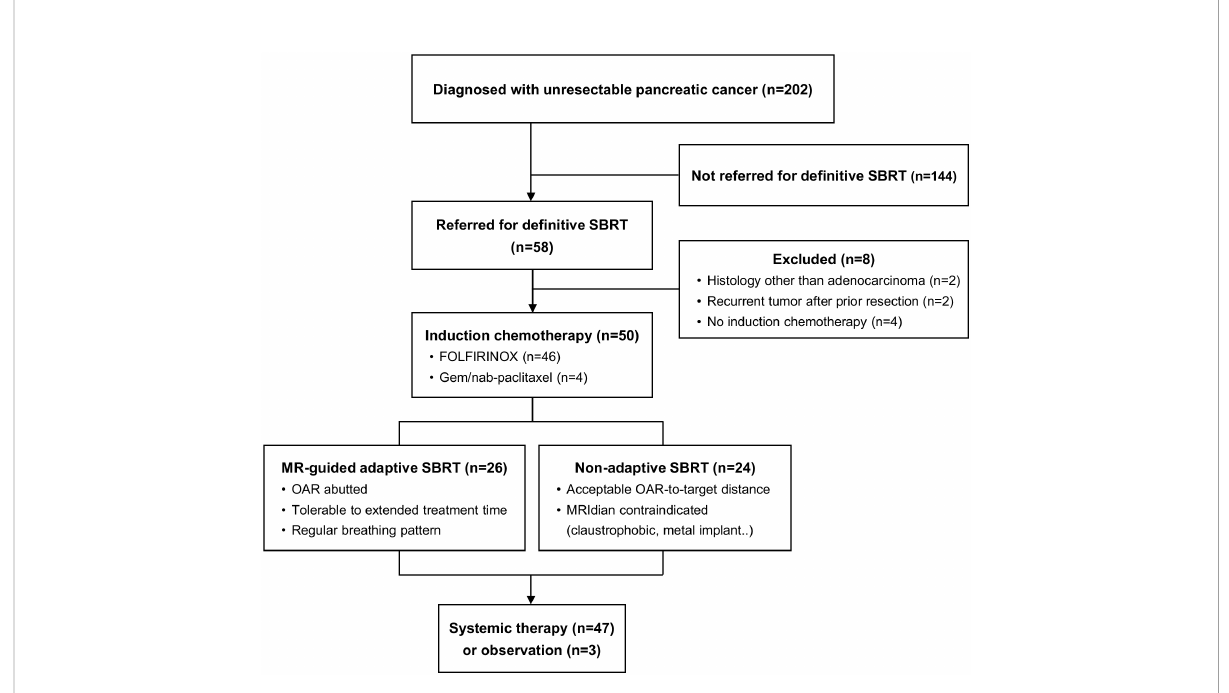
FIGURE 1 Consort diagram. MR, magnetic resonance; SBRT, stereotactic body radiotherapy; OAR, organs at